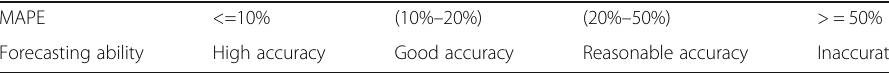
Table 1 A scale of judgment of forecast